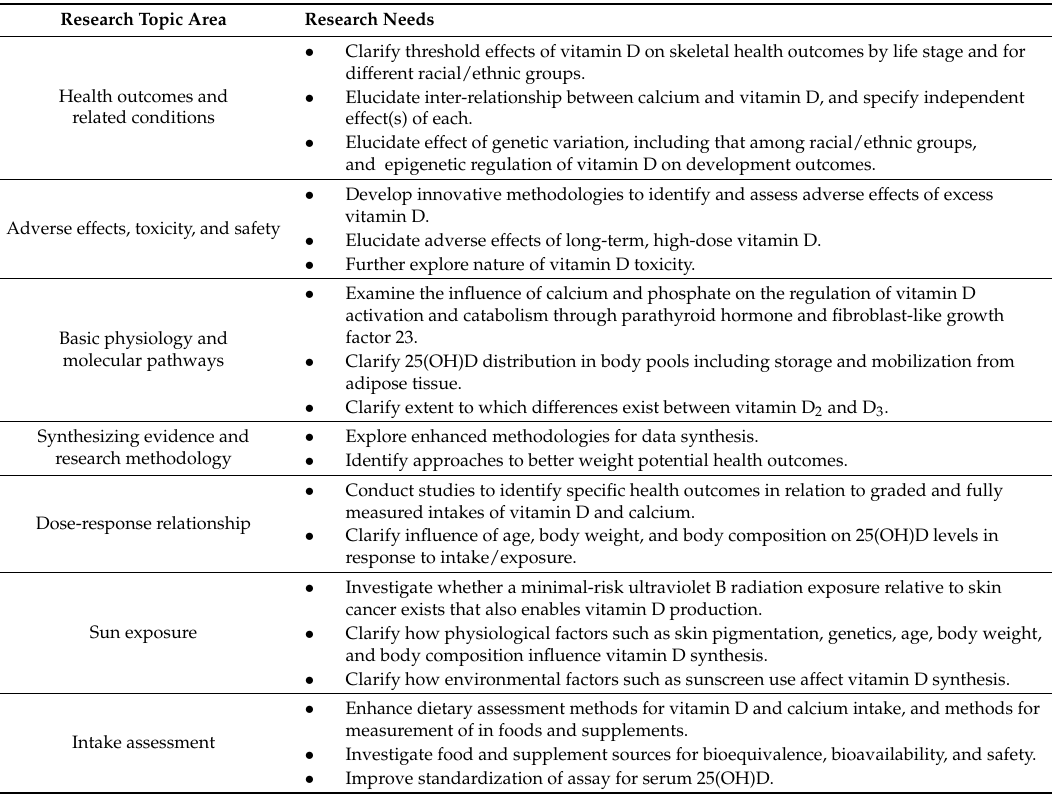
Table 6. Examples of research gaps identified during development of Dietary Reference Intakes for vitamin D 1